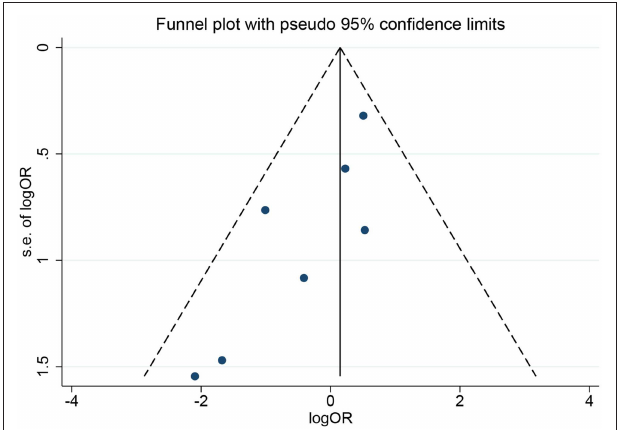
FIGURE 6 | Funnel plots of OS show a low risk of publication bias.